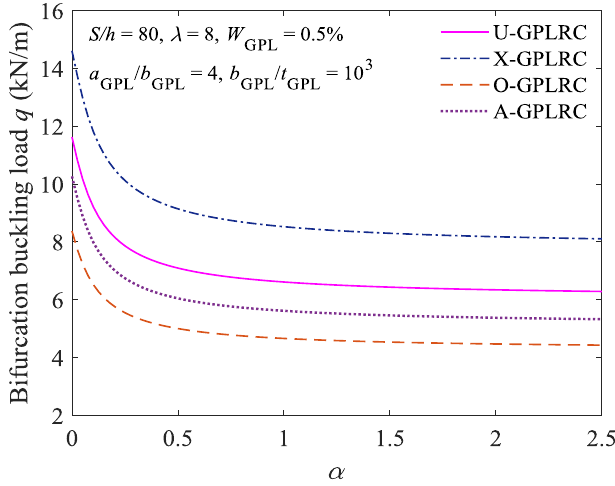
Figure 8. Effect of constraint stiffness on bifurcation buckling load.